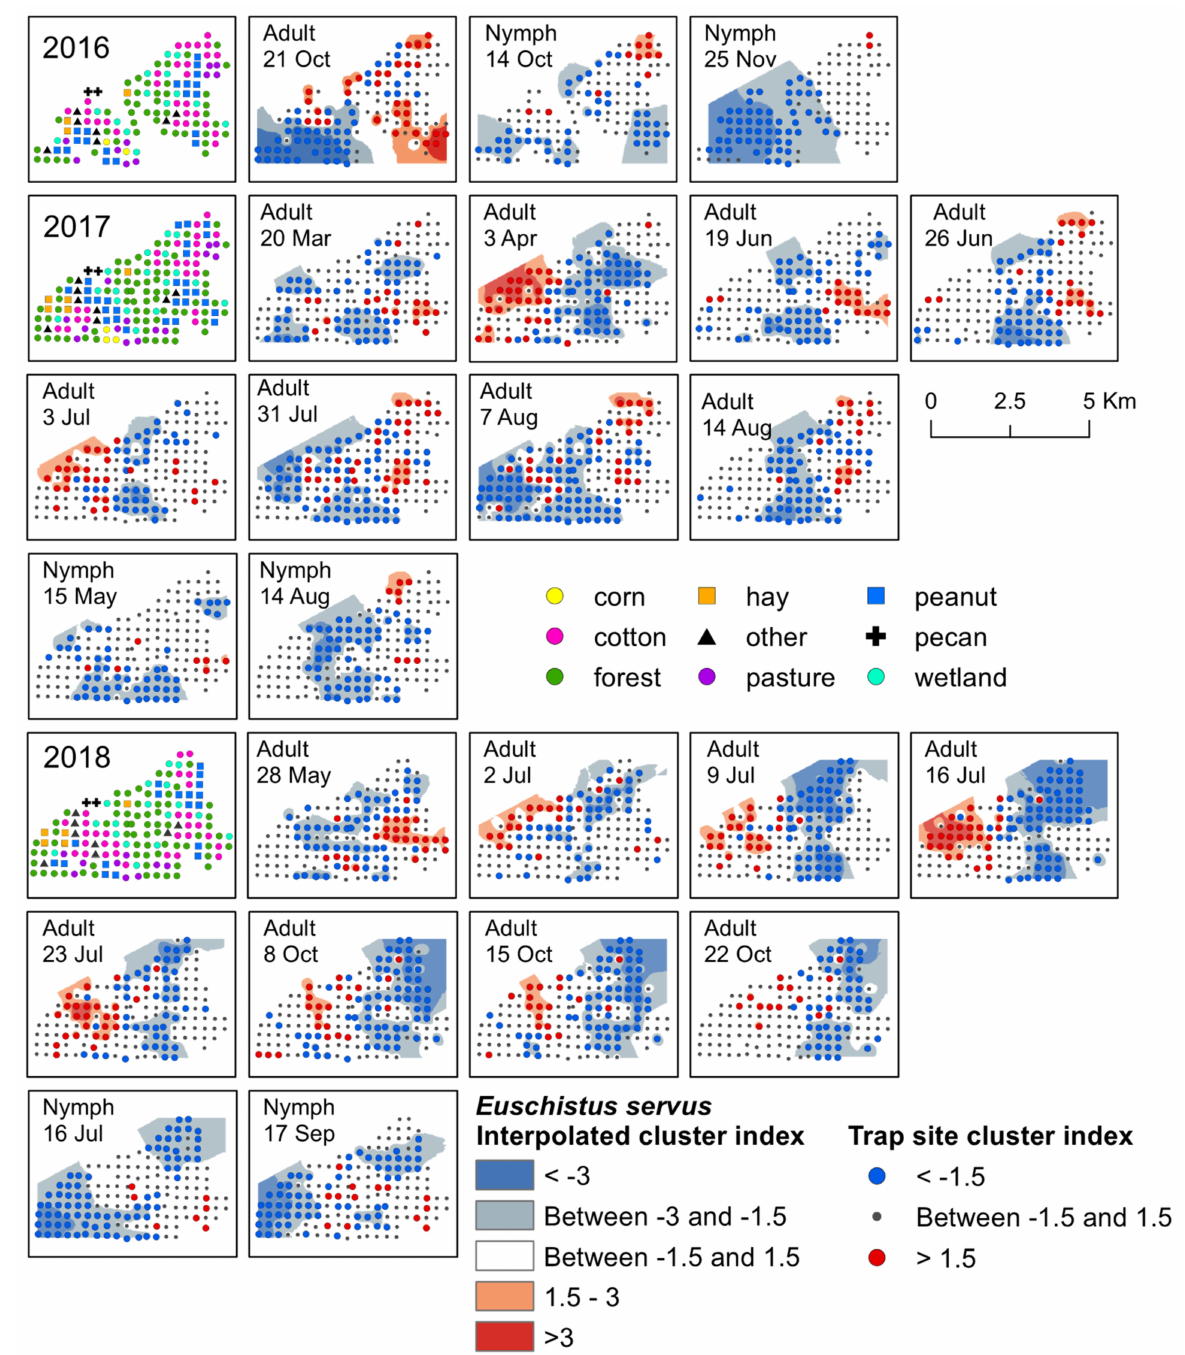
Figure 2. Red–blue plots based on interpolation of the cluster index for E. servus adults and nymphs from 2016–2018. Red areas (>1.5) indicate significant clustering in aggregations in distributions; blue areas (< − 1.5) indicate significant clustering as gaps in